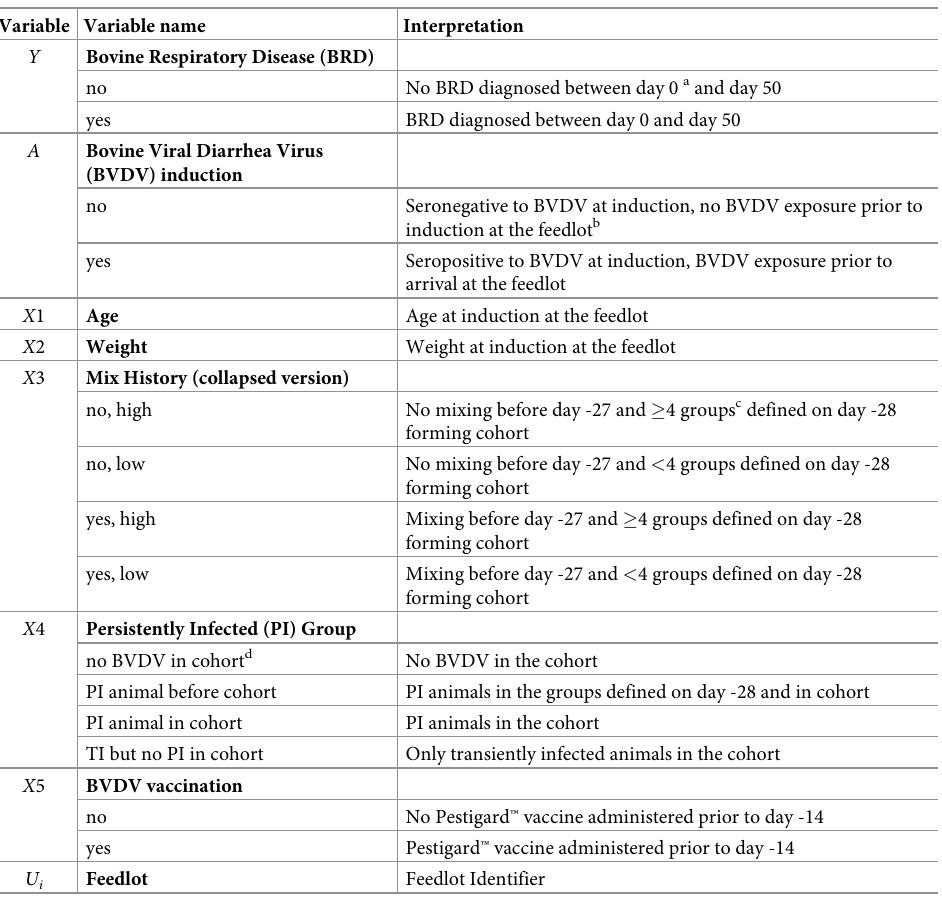
Table 1. Table of variables from NBRDI data.